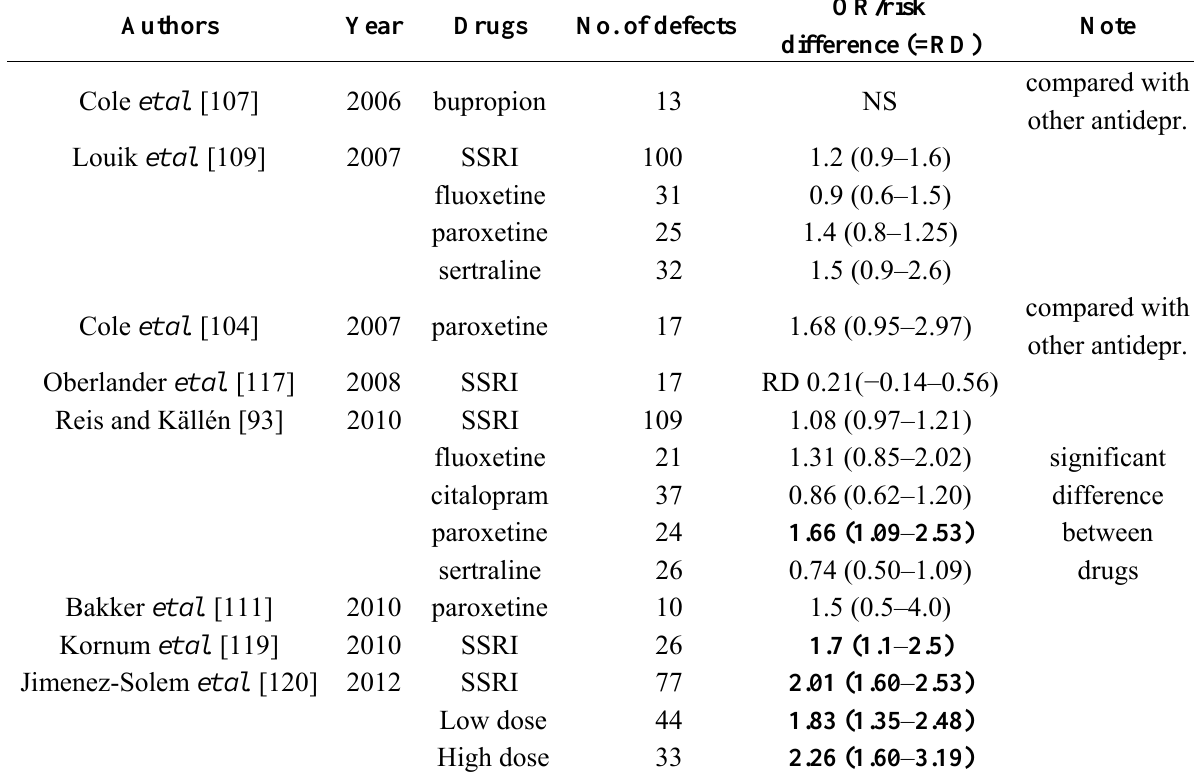
Table 30. Publications giving risks for cardiovascular defects after maternal use of antidepressants. Bold text marks statistical